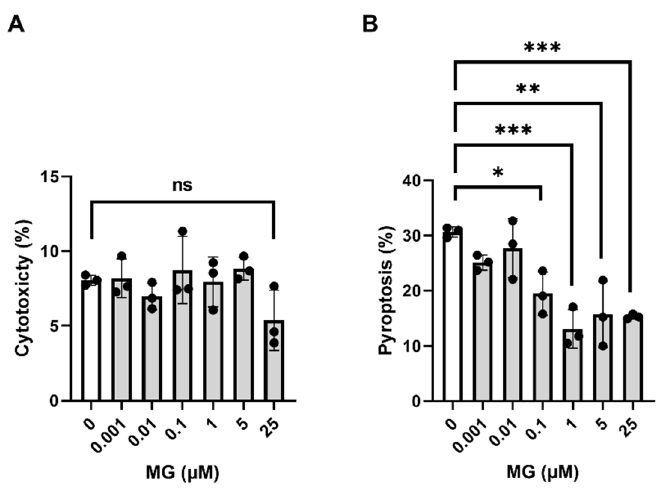
Figure 2. ( A ) Cytotoxicity exerted by increasing concentrations of MG. The LDH released by primary microglia cultures treated with MG concentrations ranging from 0.001 to 25 µ M was determined. ( B ) Antipyroptotic effect of MG. Primary microglia cultures were pre-treated with DMSO (control) or increasing concentrations of MG prior to pyroptosis induction with LPS and ATP. Pyroptosis was determined by measuring cell death using an LDH assay. Experiments were run in triplicate, and samples were in technical duplicates. Statistical significances are referred to control samples (cells pre-treated with the same DMSO% for panel ( A ) and the same DMSO% and LPS + ATP for panel ( B ). All graphs represent mean ± s.e.m. Scatter plots represent individual values depicted as black dots. Significance levels, as calculated by one-way analysis of variance, are indicated as: ( A ) 0 vs. 25 µ M: ns (no significant), p = 0.1702; ( B ) 0 µ M vs. 0.1 µ M: * p = 0.0107; 0 µ M vs. 1 µ M: *** p = 0.0002; 0 µ